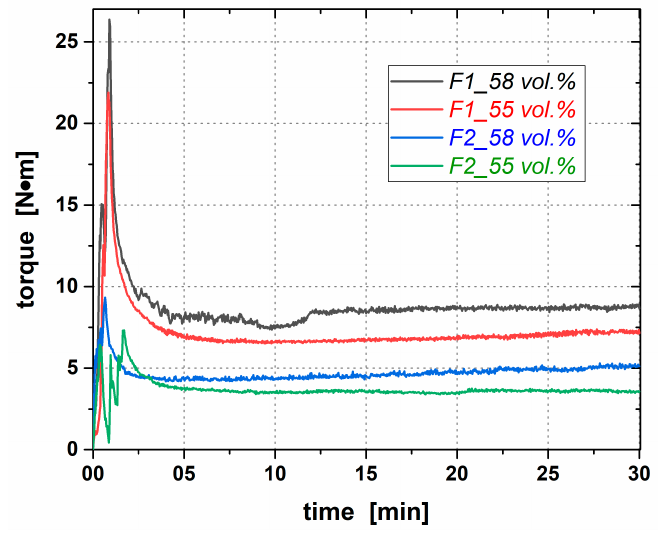
Figure 8. Mixing characteristics of PVB-/PEG-based molding compounds with different quantities of PVB- to PEG-ratio for filler degrees of 55 and 58 vol.% alumina powder.